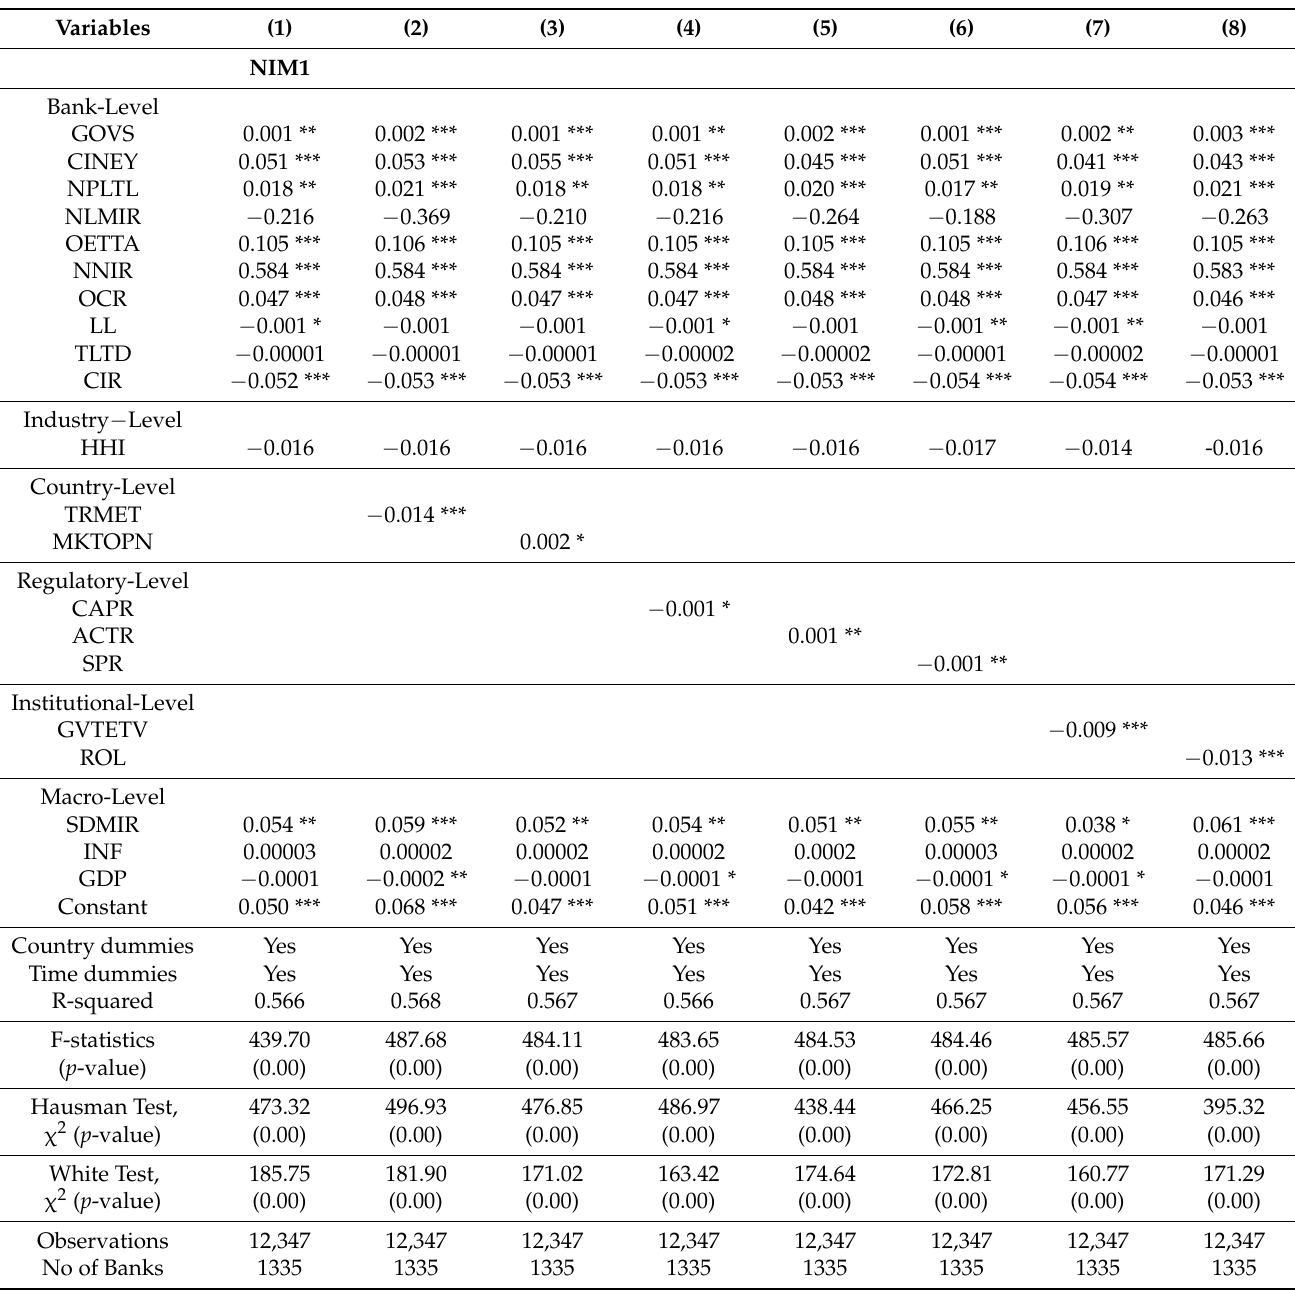
Table 4. Determinants of the cost of financial